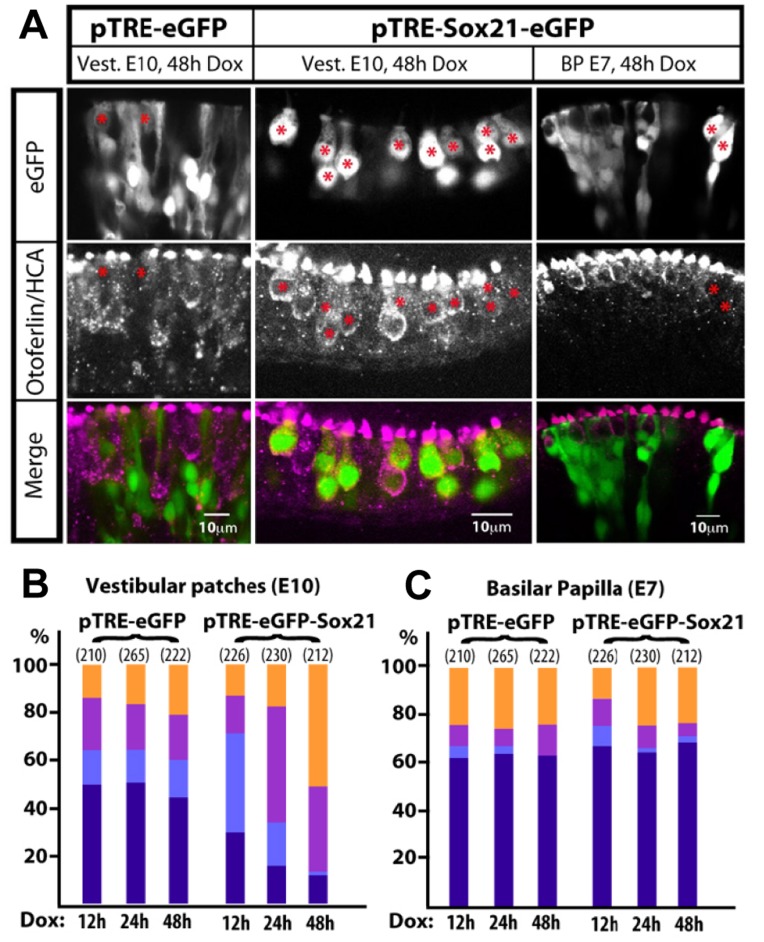
Induction of Sox21 expression at late embryonic stages promotes hair cell formation in vestibular patches, but not in the basilar papilla.(A) cultures of transfected inner ear tissue treated for 48 hours with Dox, then immunostained for otoferlin/HCA. With the pTRE-eGFP vector, eGFP-positive cells are mainly uncommitted progenitor/support cell types but include some hair cells (red asterisks). Induction of Sox21-eGFP in vestibular sensory epithelia for 48 hours results in a large majority of induced cells exhibiting a hair cell phenotype (red asterisks). In the basilar papilla, induction of Sox21-eGFP for 48 hours produces a phenotype indistinguishable from that of the control. (B–C) Phenotypic distribution (colors correspond to those used in Figure 3D) of eGFP-positive cells after 12, 24 and 48 hours Dox treatment. In vestibular sensory epithelia, Sox21 induction caused a strong shift towards hair cell phenotypes over time. Total cell counts from 3 separate ear samples are shown above bars.